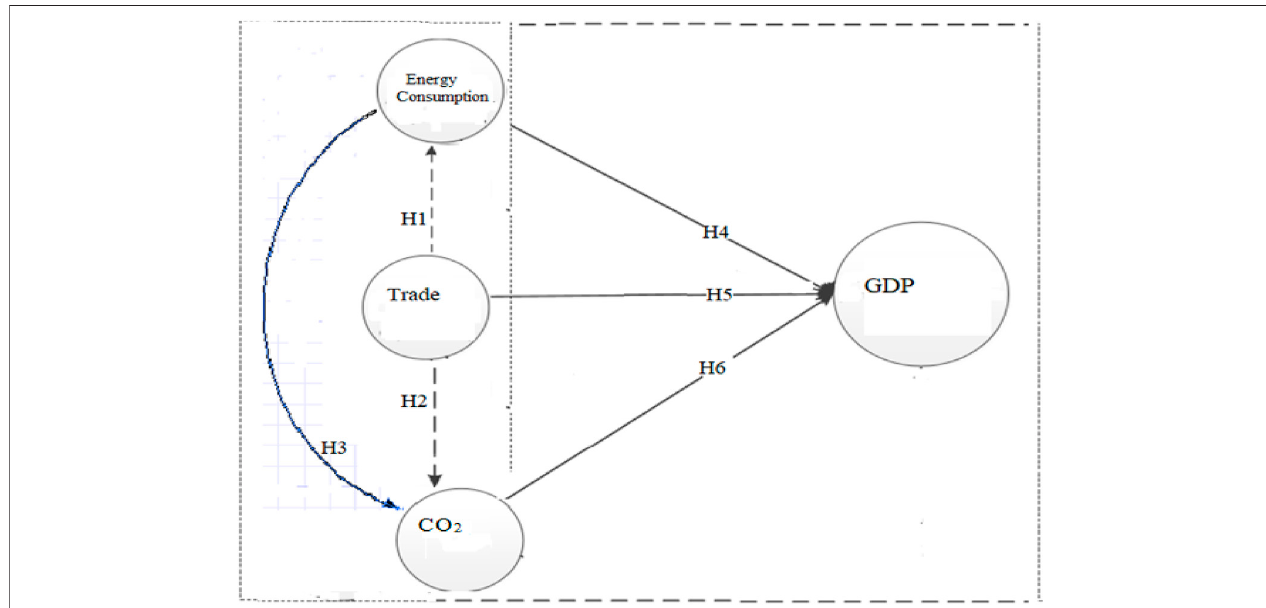
FIGURE 9 | Conceptual model of the